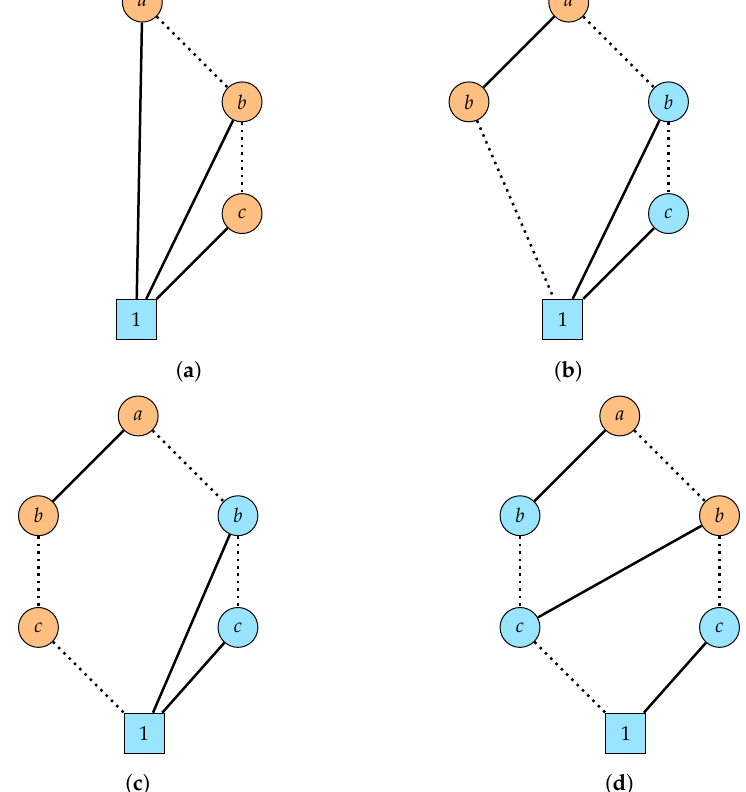
Figure 9. Traditional building of XOR(a, b, c). ( a ) Applying a ∨ b ∨ c . ( b ) Applying ¬ a ∨¬ b . ( c ) Applying ¬ a ∨ ¬ c . ( d ) Applying ¬ b ∨ ¬ c